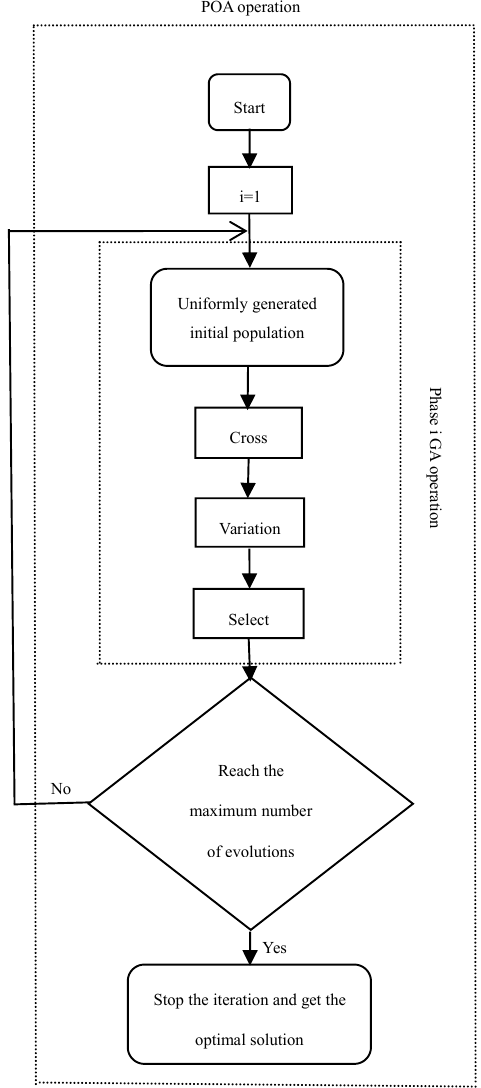
Figure 1. The modified GA-POA method solving